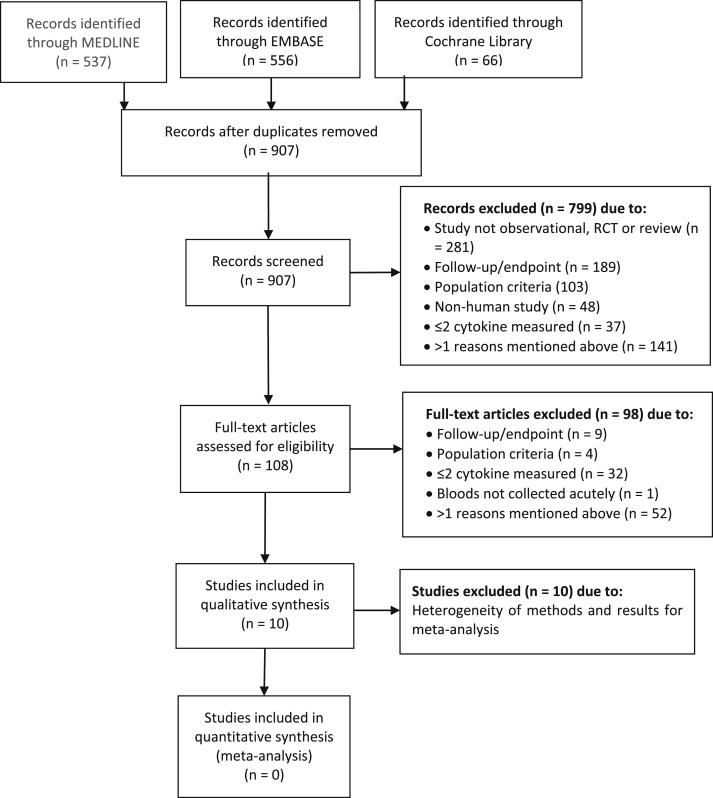
PRISMA flow diagram of selection process [26]. RCT = randomised controlled trial.